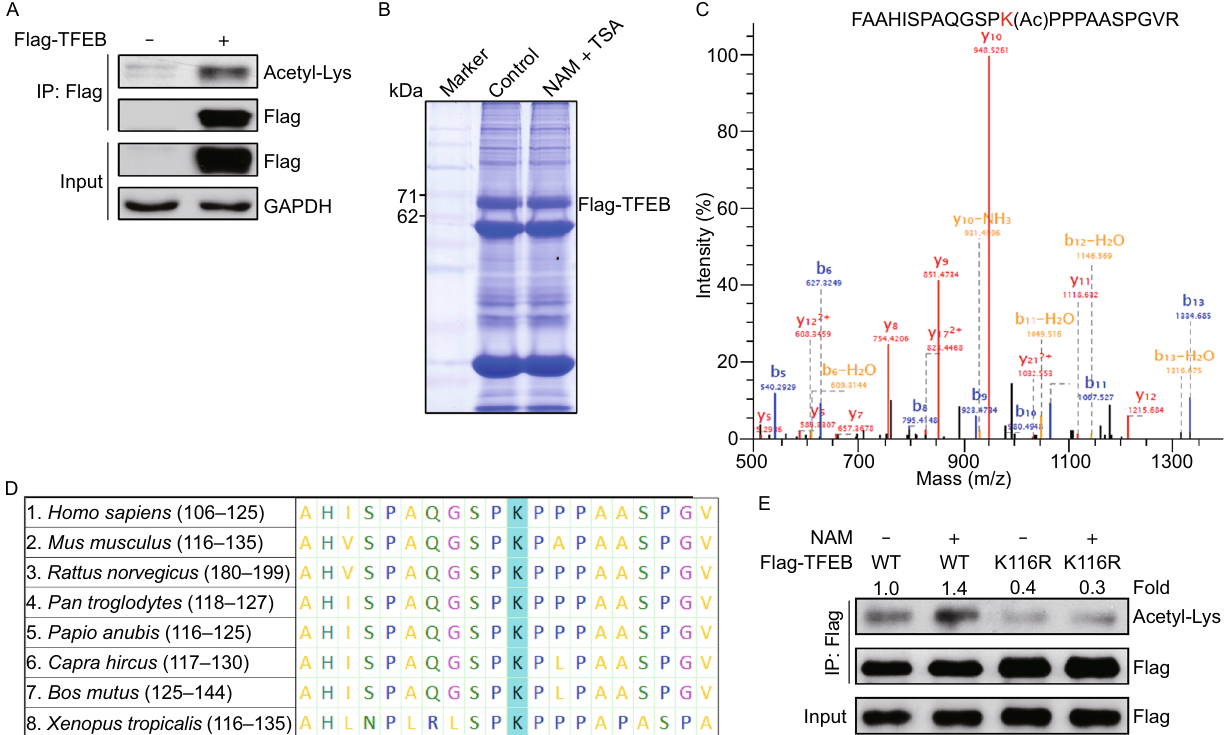
Figure 3. TFEB is acetylated at lysine 116. (A) Exogenous expressed TFEB is acetylated. Empty vector or Flag-tagged TFEB was transfected into HEK293Tcells for 24 h treated with sirtuins inhibitor NAM (10 mmol/L) and HDAC I, II, and IV inhibitor TSA (0.5 μ mol/L) and was immunoprecipitated for acetylation Western blotting analysis with the antibody against acetylated lysine. (B) Immunopre- cipitated Flag-tagged TFEB for mass spectrometry analysis. Flagged-tagged TFEB was transfected into HEK293Tcells for 24 h treated with or without NAM (10 mmol/L) and TSA (0.5 μ mol/L) and was immunoprecipitated with anti- fl ag af fi nity agrose beads, followed